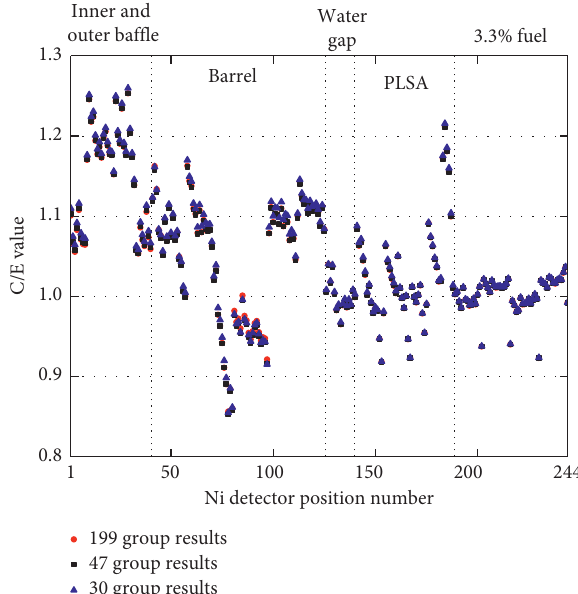
Figure 8: Comparison of group structure of the 58 Ni(n,p) 58 Co detector.